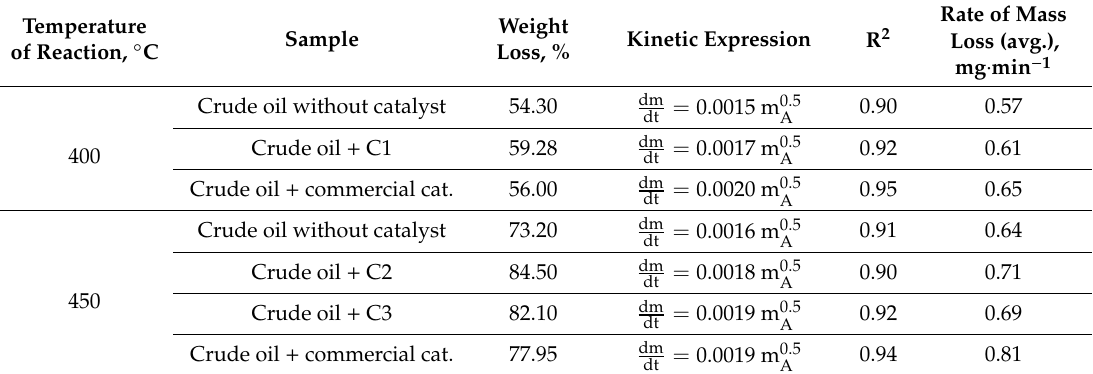
Table 2. E ff ect of the catalyst on the weight loss of crude oil on the thermal decomposition reaction. Temperature Sample of Reaction, ◦ C